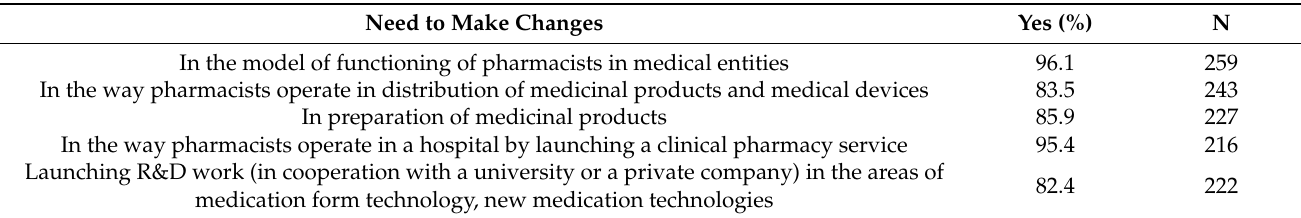
Table 3. Need for change